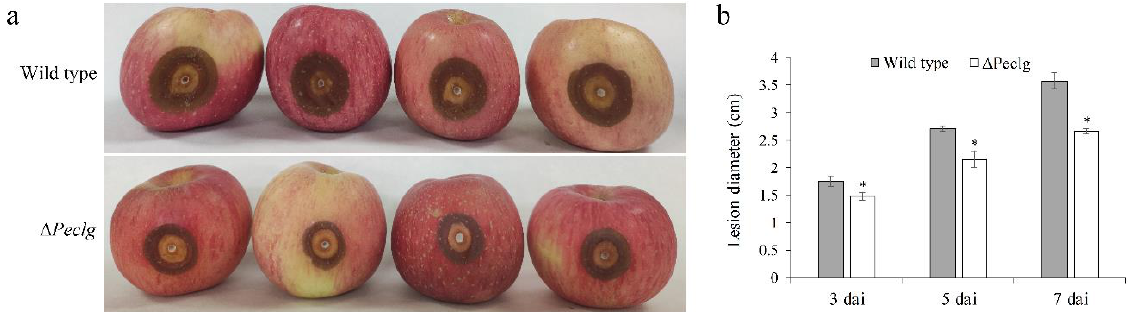
Figure 5. Blue mold lesions on apple fruits caused by the wild-type and ∆ Peclg strain of Penicillium expansum 7 d after inoculation (dai) ( a ) and a graphical presentation of the lesion diameter at 3, 5, and 7 dai ( b ). Data are presented as means ± SD of three replicates, and each replicate contains four apples. Asterisks indicate statistically significant differences ( p < 0.05) between strains.